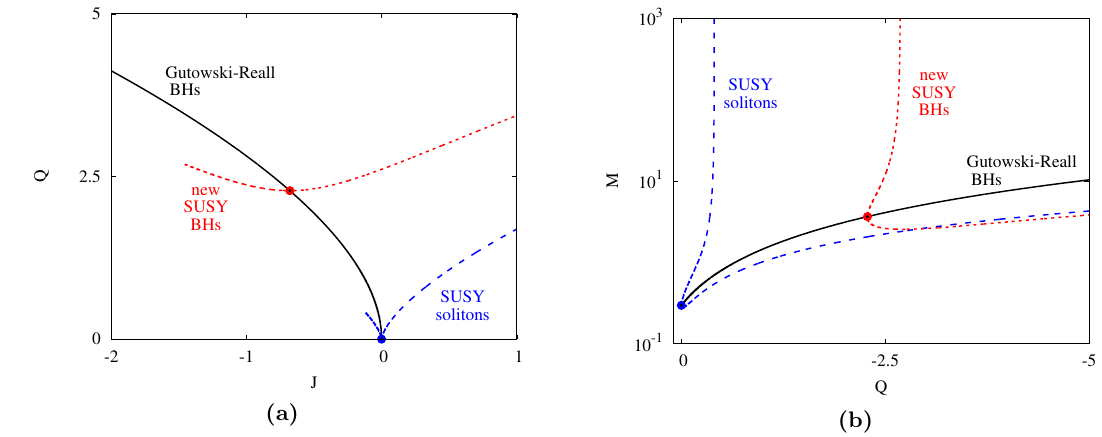
Figure 2. (a) The electric charge-angular momentum diagram is shown for the supersymmetric solitons in [19], the Gutowski-Reall BHs [10] and the new supersymmetric BHs in this work. (b) A similar (cid:12)gure with the mass-electric charge diagram for the three families of supersymmetric